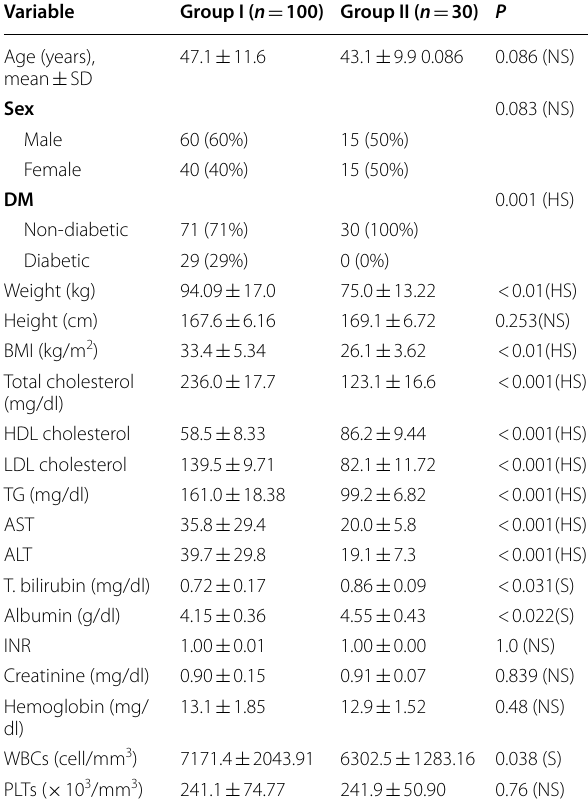
Table 1 Socio-demographic characters, anthropometric measurements, and basic lab findings among the studied